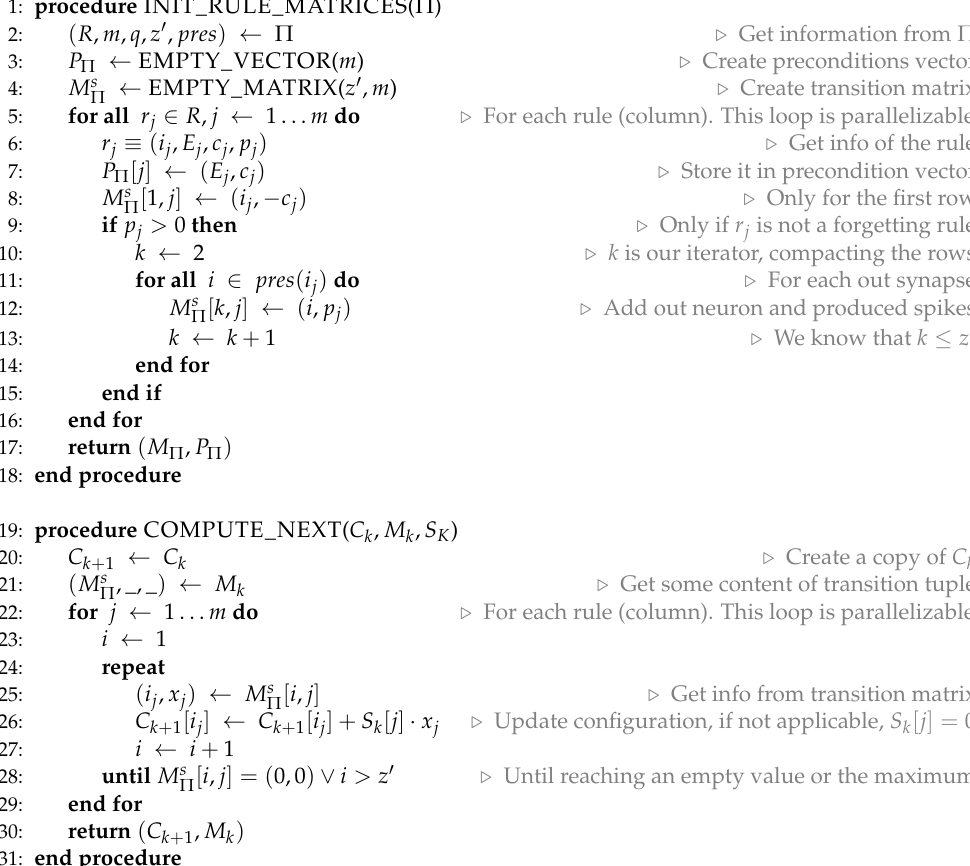
Figure 3. Illustration of compressed representation based on the ELL format of a static spiking neural P (SNP) system. Light cells are empty values (0,0). The first column is a forgetting rule (there is no need to use p = 0). The rows below the spiking vector illustrate threads, showing the level of parallelism that can be achieved; i.e., each column and each position of the spiking vector in parallel can be processed in parallel. Algorithm 5 Functions for static SNP systems with ELL-based matrix